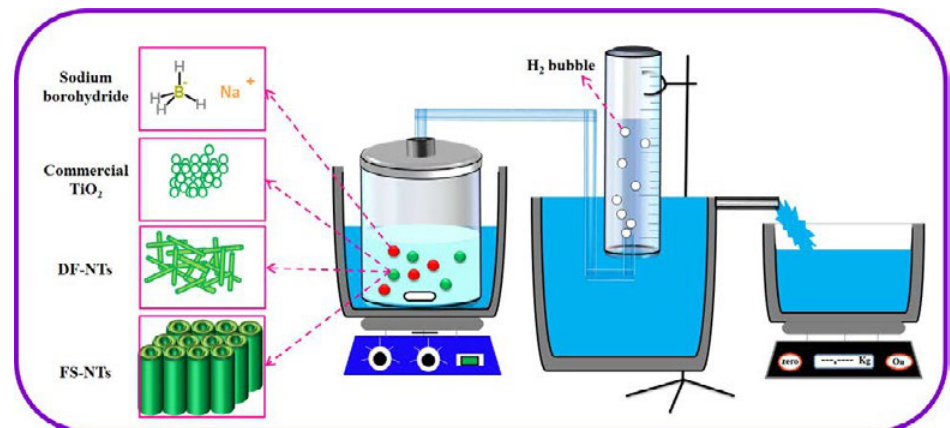
Fig. 1. Schematic corresponding to the experimental setup for generating